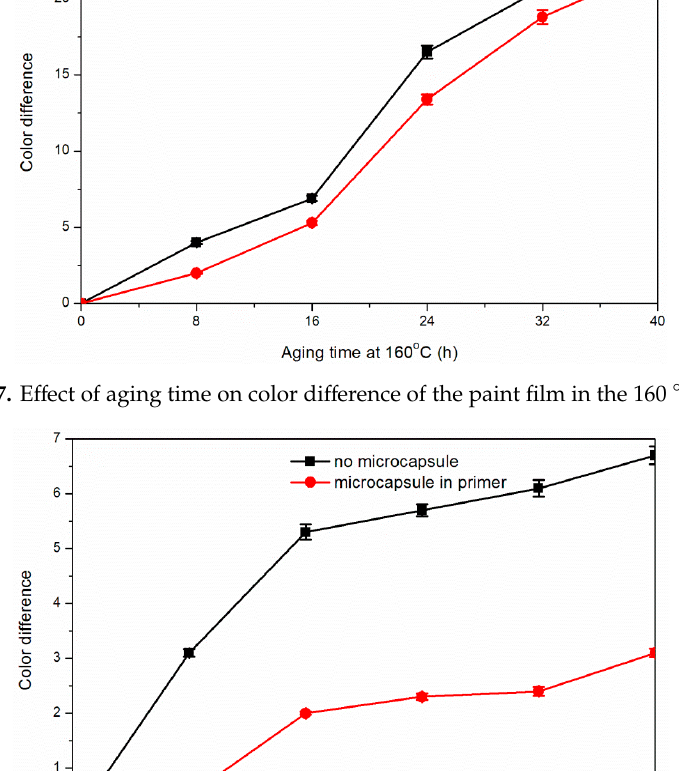
Figure 6. Effect of aging time on color difference of the paint film in the 120 °C oven.